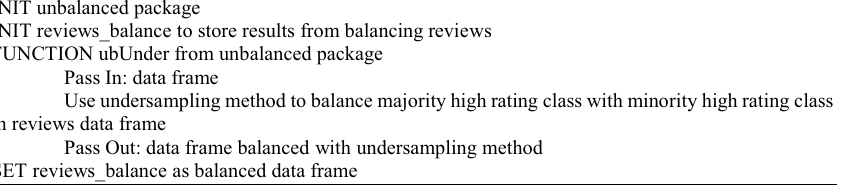
Table 5 Pseudocode to balance the dataset between majority binary class and minority binary class using the undersampling method INIT unbalanced package INIT reviews_balance to store results from balancing reviews FUNCTION ubUnder from unbalanced package Pass In: data frame